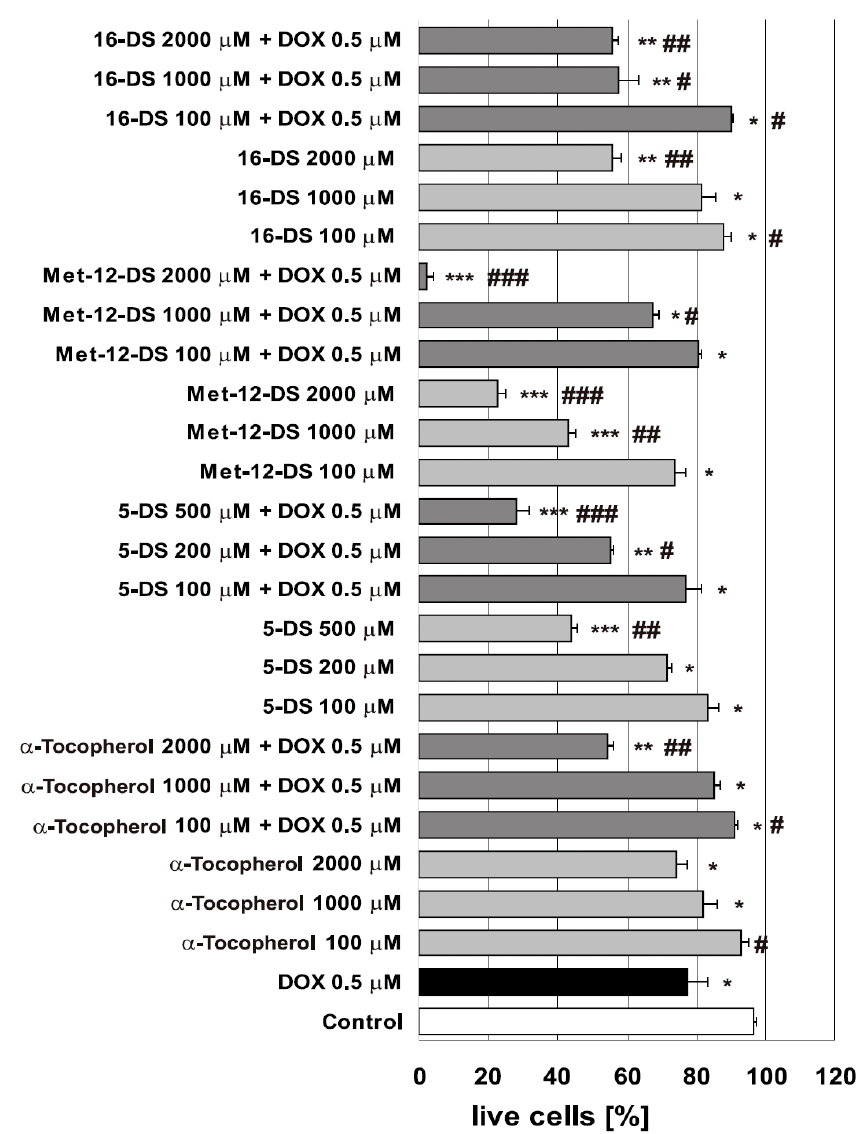
Figure 2. Cell viability of B14 fibroblasts determined by the trypan blue exclusion test. The cells were incubated for 3 h with α -Tocopherol and doxyl stearate nitroxides: 5-DS, Met-12-DS, and 16-DS or for 2 h with doxorubicin (DOX). In combined treatment cells before incubation with DOX were pretreated for 1 h with α -Tocopherol or with any of the doxyl stearate nitroxides. At the end of the incubation (0 h time point) with the investigated compounds, cells were stained with trypan blue (0.2% final concentration of the dye). All cells and blue stained dead cells were counted with an Olympus IX70 microscope (Tokyo, Japan), and the fraction of live cells was calculated as a percentage of all cells (100%). The data are shown as a mean ± SD of three independent experiments, each in at least three repeats.* p < 0.05 vs. control; ** p < 0.005 vs. control; *** p < 0.001 vs. control; # p < 0.05 vs. DOX; ## p < 0.005 vs. DOX; ### p < 0.001 vs.